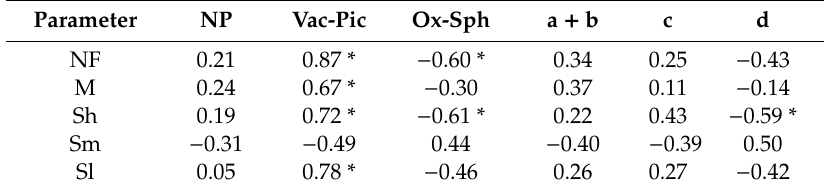
Table 9. Pearson correlation (R-coe ffi cient) between plant predictors and macromycetes.